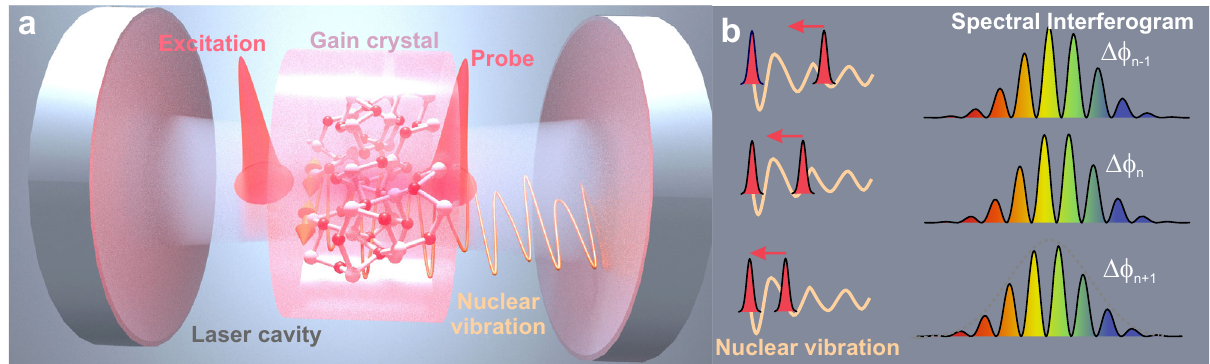
Fig. 1 Intracavity Time-domain Raman Sampling. a Two ultrashort solitons (red) circulate inside an active laser cavity: The leading soliton excites a coherent nuclear vibration (orange) in the gain crystal, the trailing pulse samples the refractive index modulation. b During the soliton approach, the trailing soliton encodes the temporal waveform of the nuclear vibration in its phase (left). We detect the relative phases at each roundtrip n , 4 ϕ fringes of single-shot interferograms